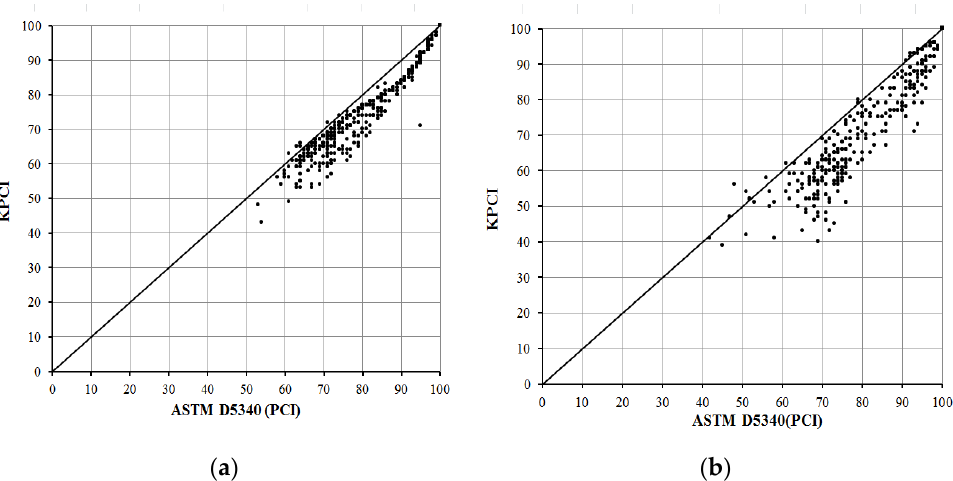
Figure 11. Comparisons of PCI between ASTM D 5340 and KPCI; ( a ) asphalt pavement, ( b ) concrete pavement.